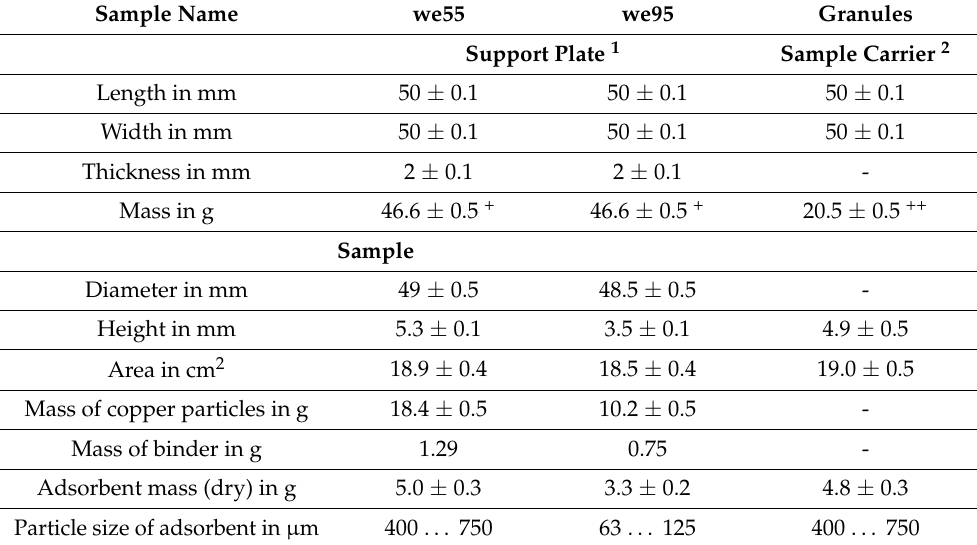
Table 1. Geometric data and mass of the adsorbent–metal composite